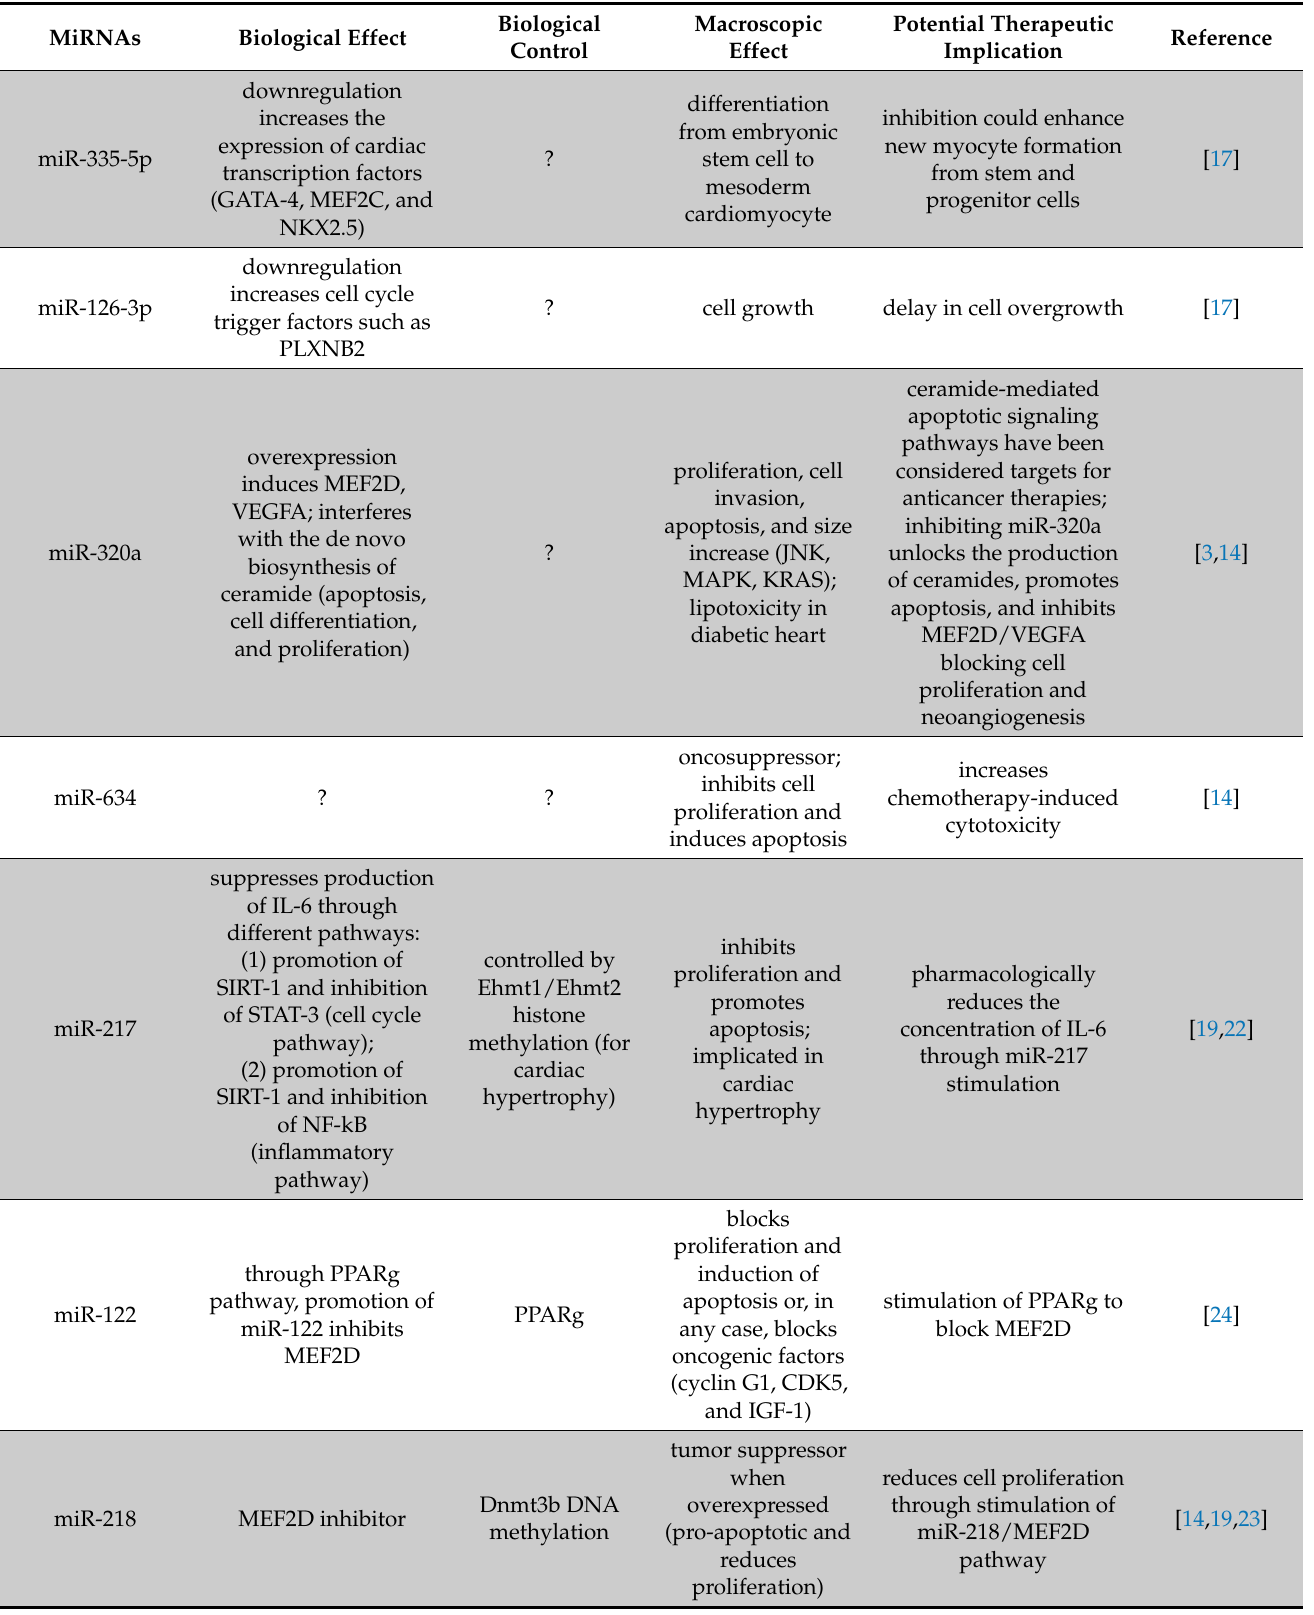
Table 1. Summary of miRNAs implicated in cardiac